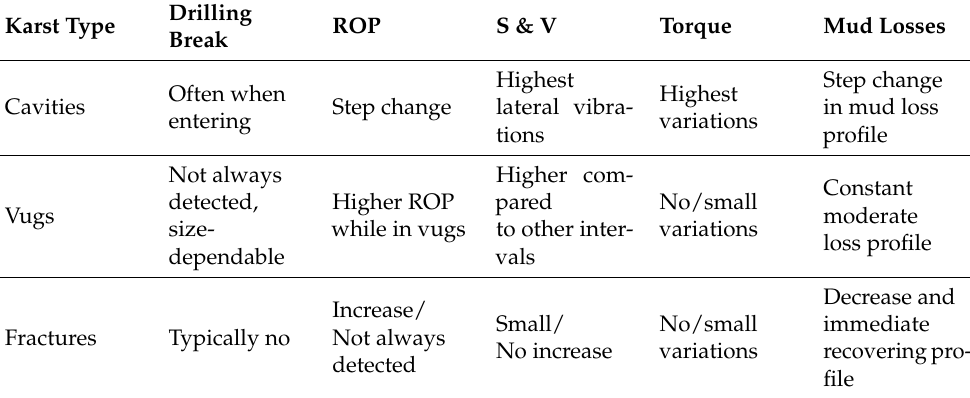
Table 1. Patterns of drilling measurements/events corresponding to karstification